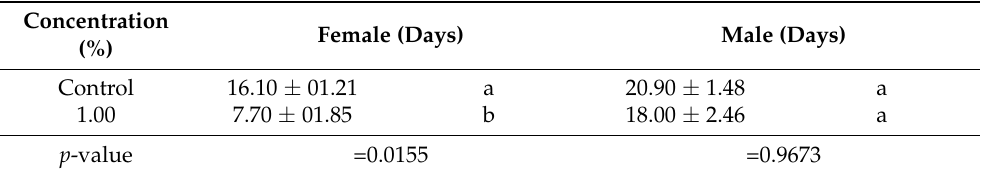
Table 3. Longevity (mean ± SE) of the adult stage of P. xylostella males and females exposed to different M. albicans extract